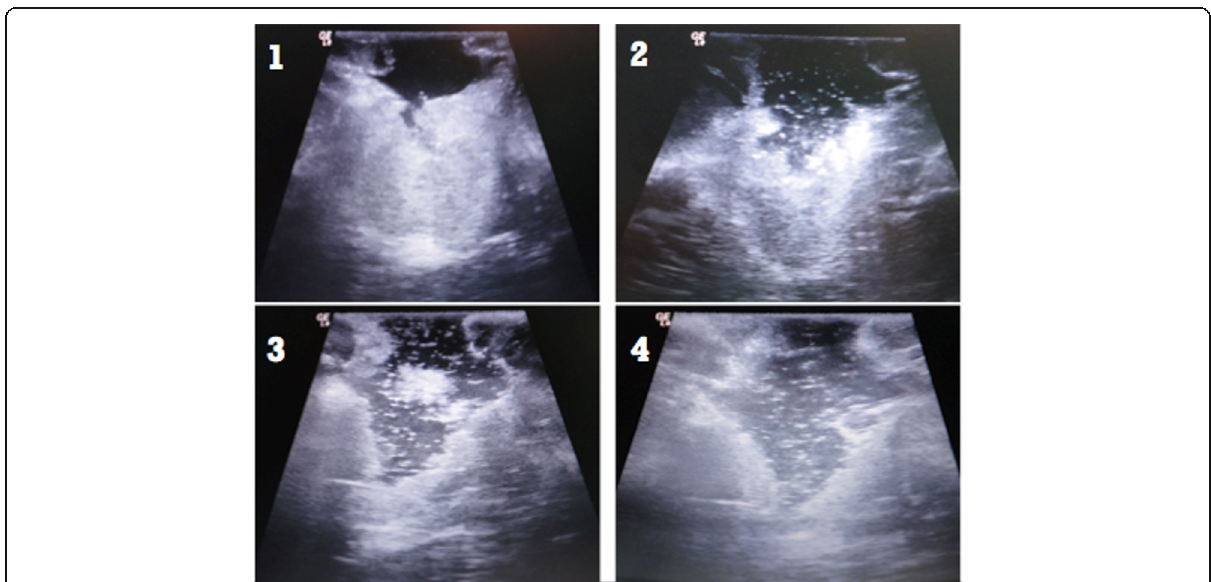
Fig. 4 Stages of tumor resection from 1 to 4 showing ultrasound ability to assess the degree of resection and residual